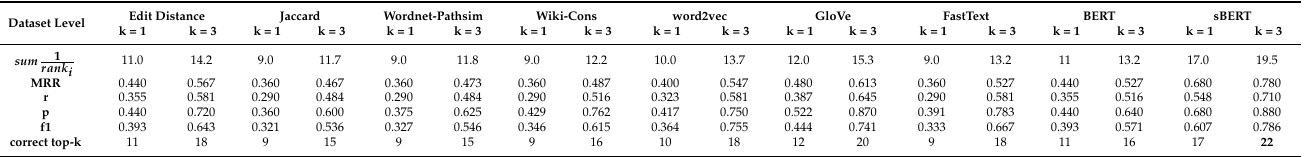
Table 7. Evaluation of dataset-level matching